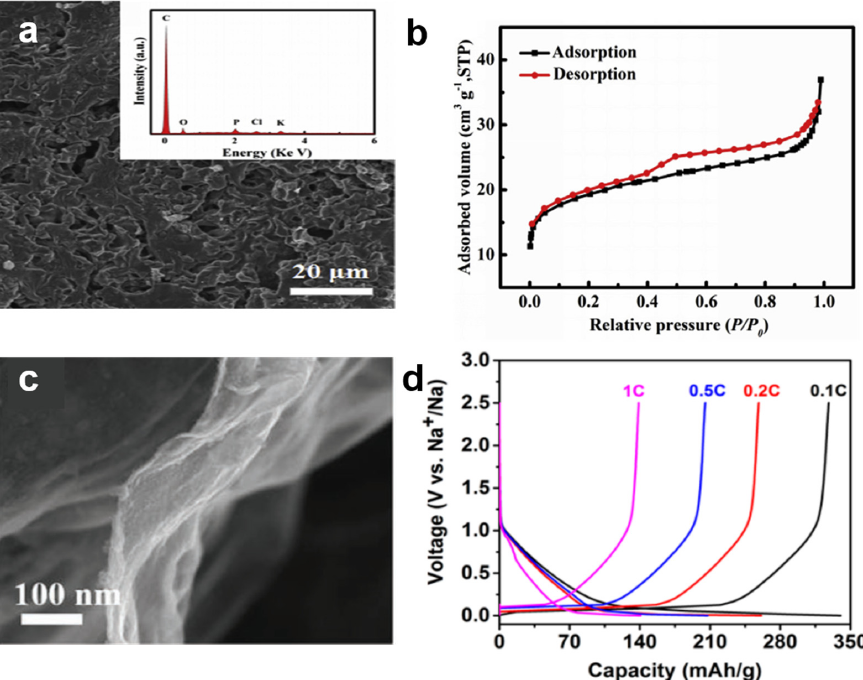
Figure 4. ( a ) Scanning electron microscopy (SEM) image and ( b ) N 2 adsorption–desorption isothermal curves of hard-carbon nanosheets from the pyrolysis of oat flakes. Reprinted with permission from Ref. [82]. Copyright 2019 Elsevier. ( c ) SEM image of hard-carbon nanosheets from the pyrolysis